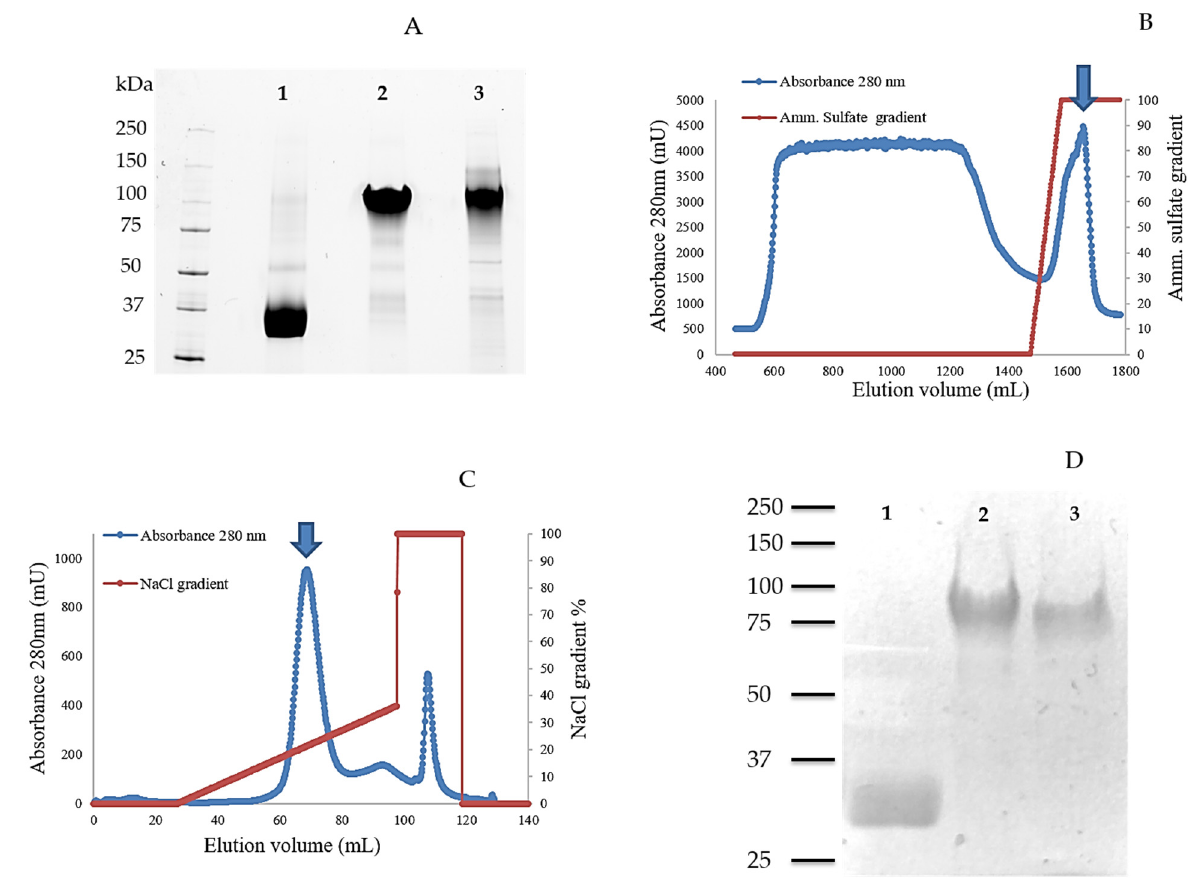
Figure 2. ( A ) Analysis of the expression of the three LPMO variants by SDS ‐ PAGE. Proteins were produced in a 5 ‐ L bioreactor using Basal Salts Medium for 4 days. Lane 1: TamAA9A ‐ CD; Lane 2: TamAA9 ‐ WT; Lane 3: TamAA9 ‐ CBM. ( B ) and ( C ) Two ‐ step chromatographic purification of LPMOs variants from T. amestolkiae . The example describes the purification of TamAA9A ‐ WT. ( B ) Hydrophobic interaction chromatography using an ammonium sulfate gradient for protein elution. ( C ) Anion ‐ exchange chromatography, using a NaCl gradient for protein elution. Peaks containing LPMO activity are marked with arrows. ( D ) Purified LPMO variants: Lane 1, TamAA9A ‐ CD; Lane 2, TamAA9A ‐ CBM; Lane 3, TamAA9A ‐ WT.